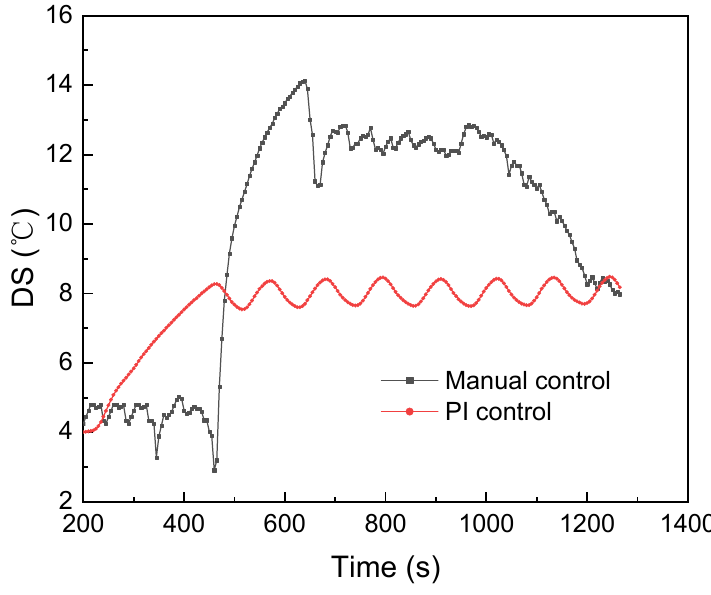
Figure 11. Manual and PI control DS response curves of EXV1, refrigerant pump opening is 60%.